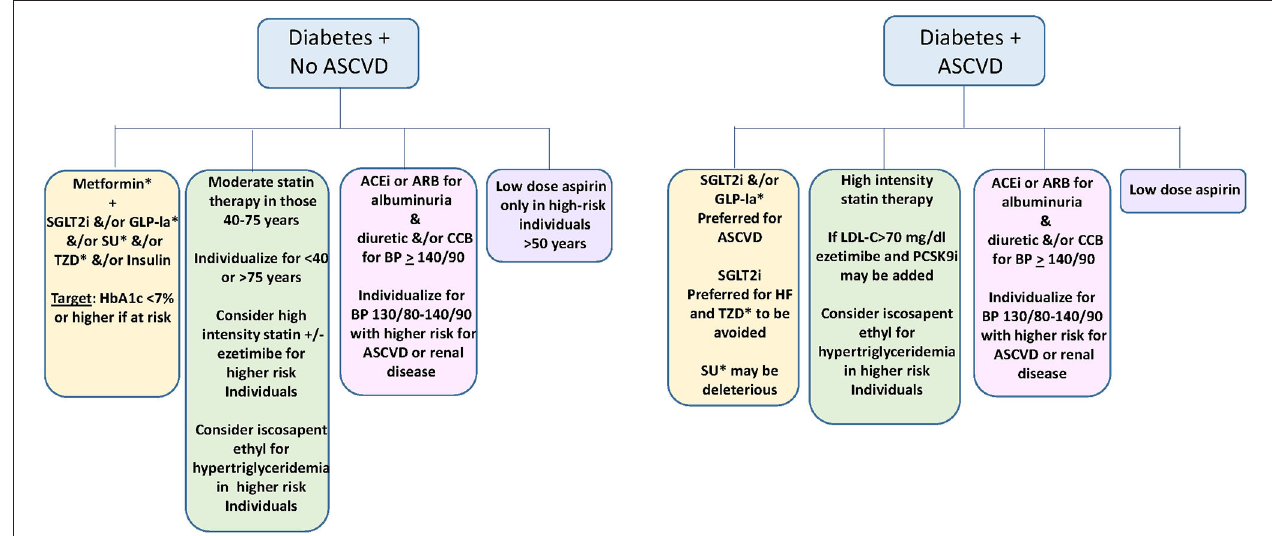
FIGURE 2 | Suggested approach to medical prevention and amelioration of ASCVD in diabetes (22–24, 41). Yellow; Glycemic control. Green: Lipid management. Pink; Blood pressure management. Violet; Use of low dose aspirin. SGLT2i, sodium glucose transporter 2 inhibitor; GLP-1a, Glucagon like peptide 1 agonist; SU, sulfonylurea; TZD, thiazolidinedione; ACEi, Angiotensin converting enzyme inhibitor; ARB, angiotensin receptor blocker; CCB, calcium channel blocker; LDL-C, low density lipoprotein cholesterol. *not used in type 1 diabetes.